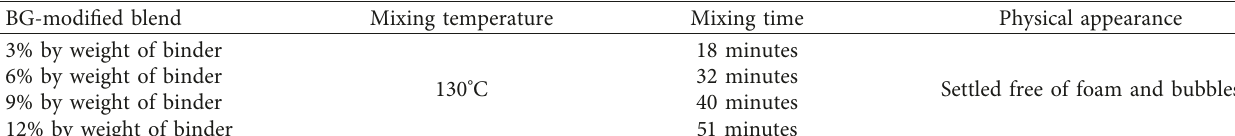
Table 3: Mixing time and temperature for preparation of modified binders